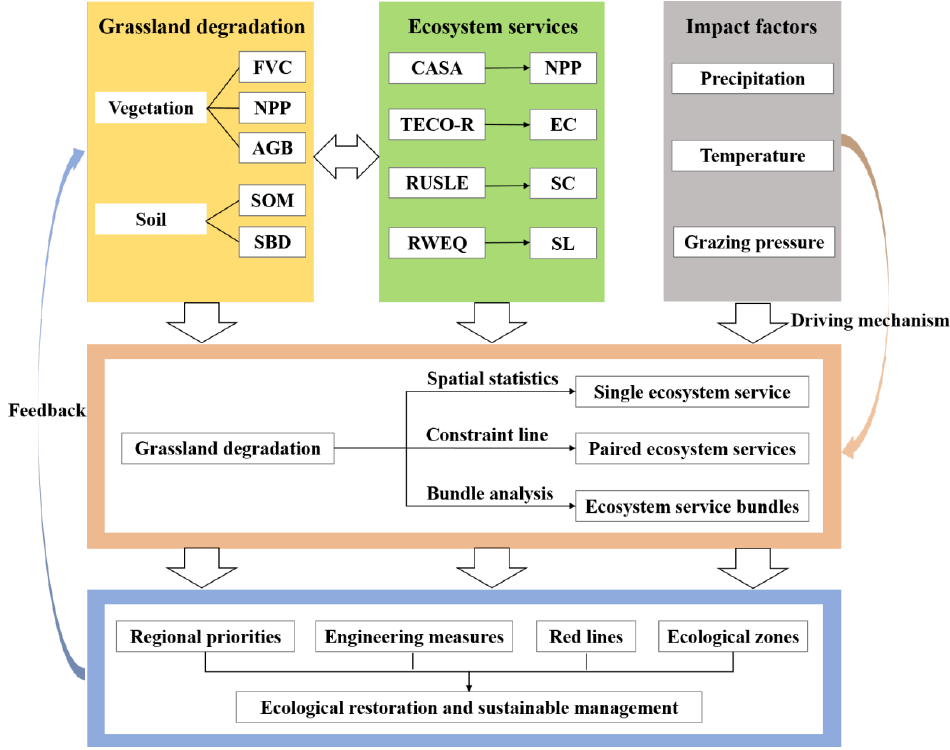
Figure 2. Research framework. FVC, fractional vegetation cover (%); NPP, net primary production (kg C/m 2 ); AGB, aboveground biomass (g/m 2 ); SOM, soil organic matter (0 – 20 cm, kg C/m 2 ); SBD, soil bulk density (0 – 20 cm, g/m 3 ); CASA, the Carnegie – Ames – Stanford Approach model; TECO-R, the improved Terrestrial Ecosystem Regional model; RUSLE, the Revised Universal Soil Loss Equation model; RWEQ, the Revised Wind Erosion Equation model; NPP, net primary production (kg C/m 2 ); EC, ecosystem carbon (kg C/m 2 ); SC, soil conservation (t/ha); SL, soil loss by wind (kg/m 2 ).